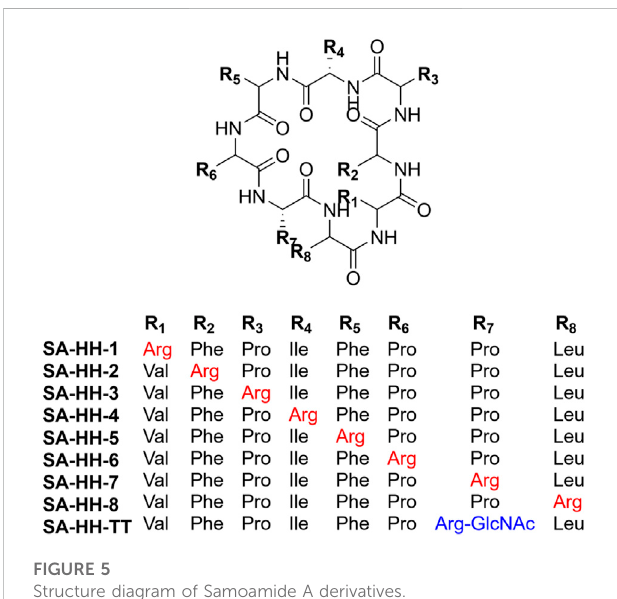
FIGURE 5 Structure diagram of Samoamide A derivatives.